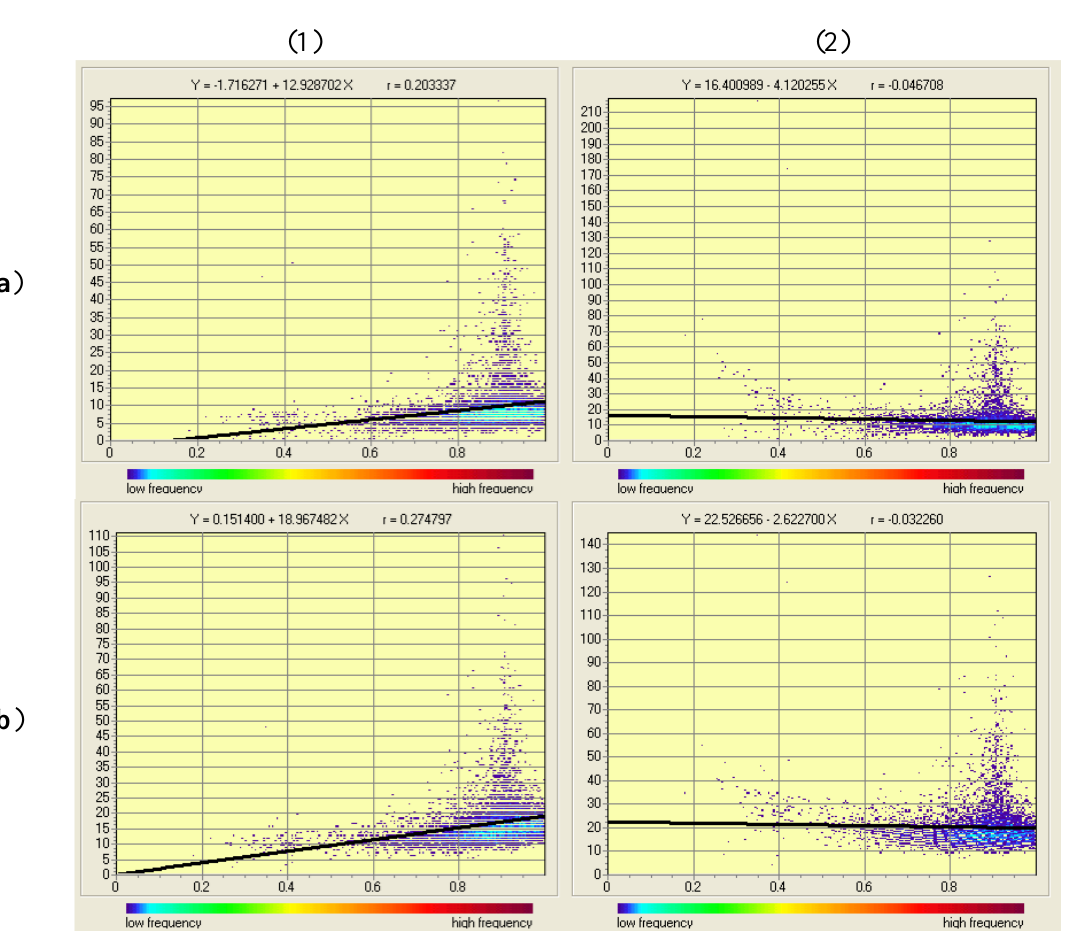
Figure 4. Regression analysis between cos i on x-axis, and the radiance values on y-axis, for ( a ) band 1, ( b ) band 2 and ( c ) band 3, for the noncorrected (1) and for the corrected radiance data (2),